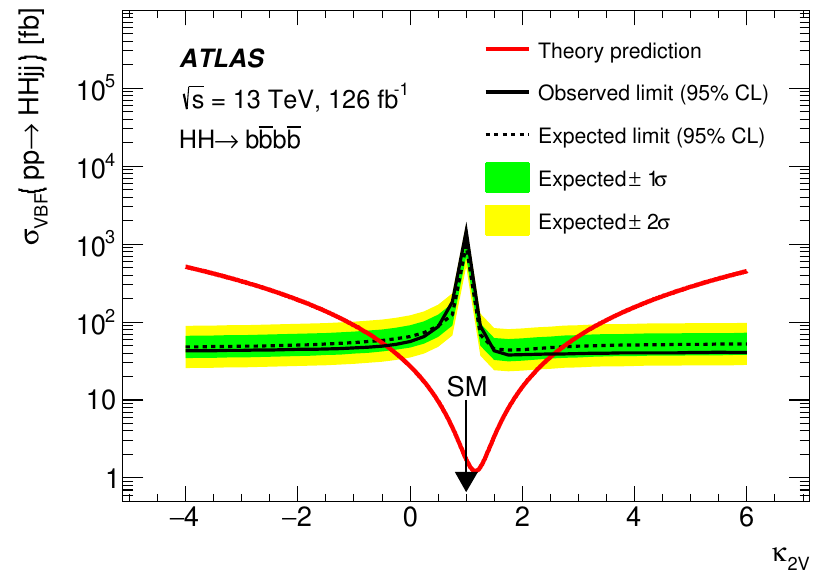
Figure 6 . Observed and expected 95% CL upper limits on the production cross-section for non- resonant HH production via VBF as a function of the di-vector-boson–di-Higgs-boson coupling modifier κ 2 V . The theory prediction of the cross-section as a function of κ 2 V is also shown. More details on the predicted cross-section can be found in section